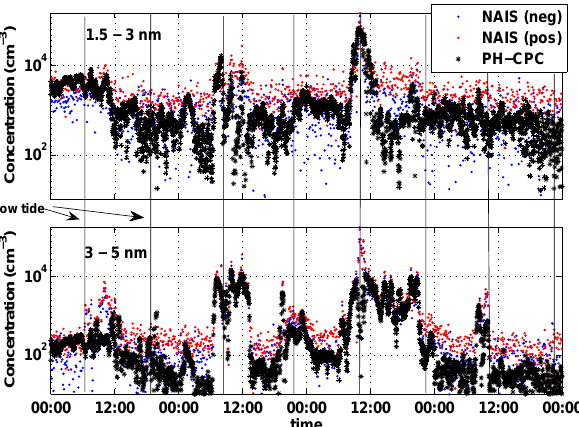
Fig. 3. Total concentration of 1.5–3nm and 3–5nm particles in Mace Head 13–16 June 2008 measured with the PH-CPC (black dots) and the NAIS (red and blue dots for positive and negative charging polarity of the instrument). Vertical lines indicate the times of low tide.